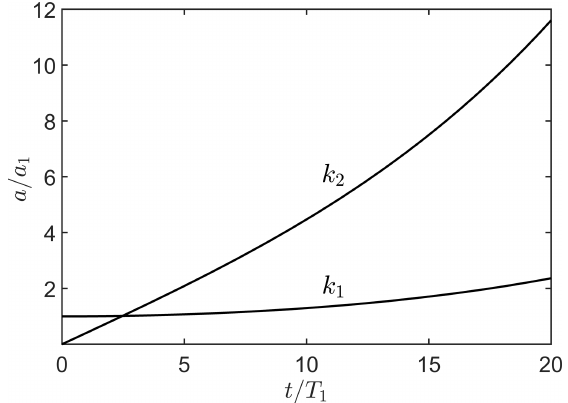
Figure 3. Growth of amplitudes of a wave on the SG − branch which resonates a wave on the same branch. The incident wave wavenumber is k 1 H = 0 . 06, while the resonant wave has the wavenumber k r H = 3 . 13. Other relevant parameters are k b H = √ √ √ g/H = − 0 . 0213, ω 2 / g/H = 0 . 0213, U/ gH = 3 . 19, ω 1 / 0 . 70, N = 2048, M = 2, a 1 s /H = 2 . 5 × 10 − 5 , a b /H = 0 . 025, and T 1 /(cid:49)T = 1024. Here, “ N ” denotes the number of Fourier modes used in numerical simulation, whereas “ M ” denotes the order of nonlinearity taken into account. (See Raj and Guha, 2019 for de-